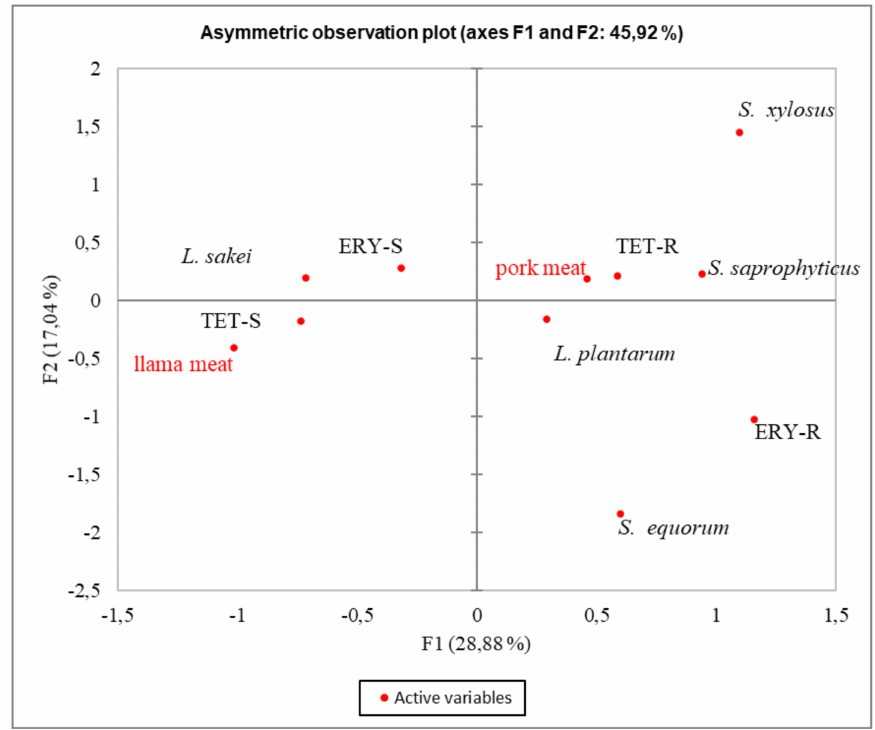
Figure 3. Multivariate correspondence analysis (MCA) summarizing the associations between antibiotic resistance phenotypes (R and S) among Latilactobacillus ( L .) sakei , Lactiplantibacillus ( L .) plantarum , and Staphylococcus ( S ) species isolated from pork meat and llama meat fermented products. The contribution to the Chi-squared test is indicated for each